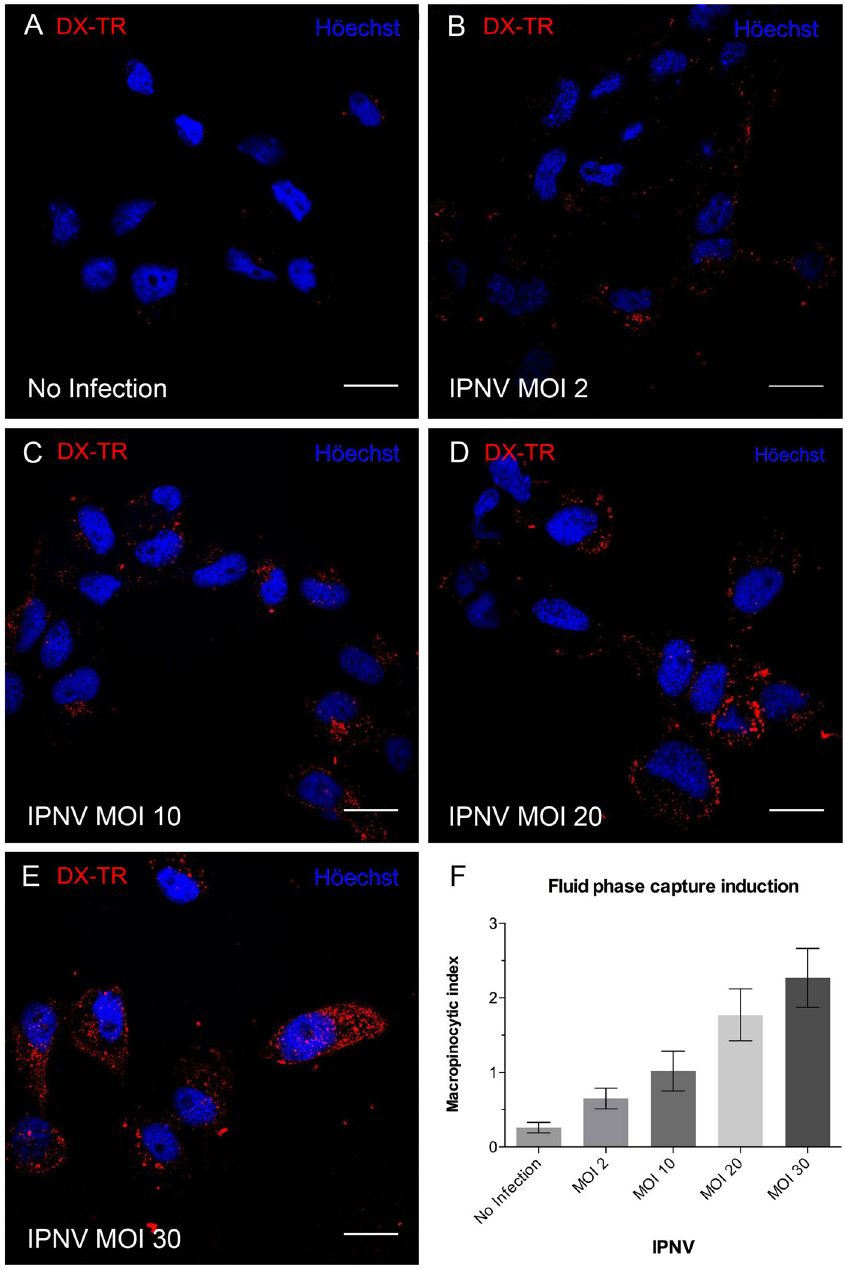
Figure 5. IPNV induces fluid phase capture in CHSE-214 cells. CHSE-214 cells were grown to 70% confluence in 24-well plates with round coverslips in MEM with 2% FBS. Cells were left for 16 h in MEM without FBS. IPNV at MOI of 0, 2, 10, 20 and 30 ( A – E ) was inoculated, then left to adsorb for 1 h at 4 °C. Dextran Texas red (250 µ g/ml) was added, and cells were incubated at 20 °C for 45 min. Cells were fixed and stained with Höechst. Images were recorded with a C2 Plus Eclipse TI Nikon confocal microscope. Representative images are shown (scale bar = 10 μ m). A graph of the macropinocytic index vs MOI is presented in F. The macropinocytic index was determined as described in Materials and